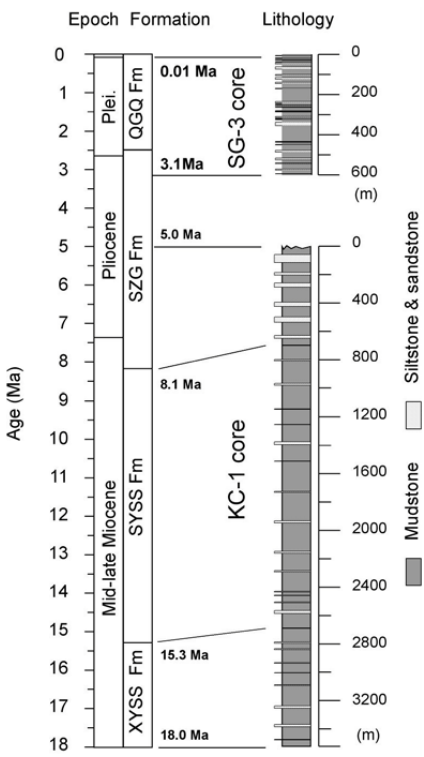
Fig. 2. Late Cenozoic stratigraphic distribution in the KC-1 (Miao et al., 2011) and SG-3 (Cai et al., 2012)